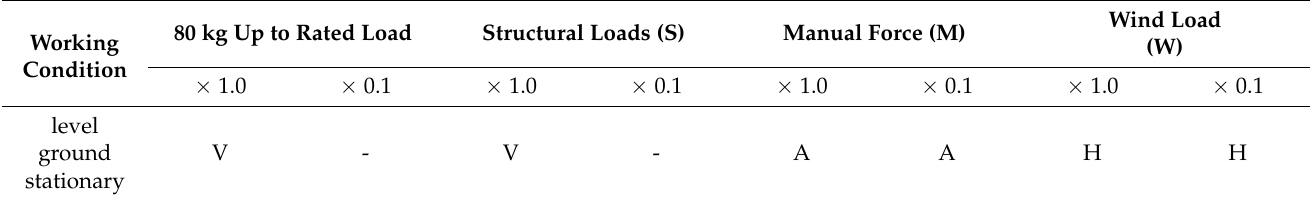
Table 7. The load and force directions for stability calculations for scissor lift [17].